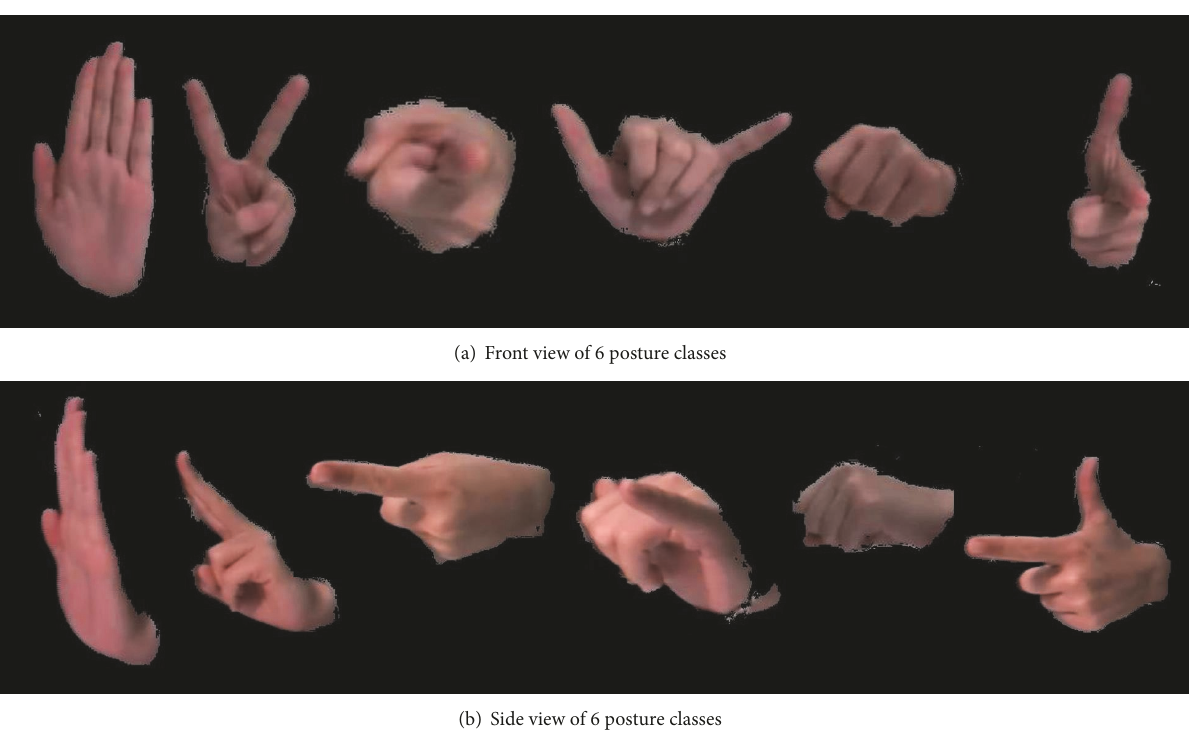
Figure 25: The front view and side view of 6 posture